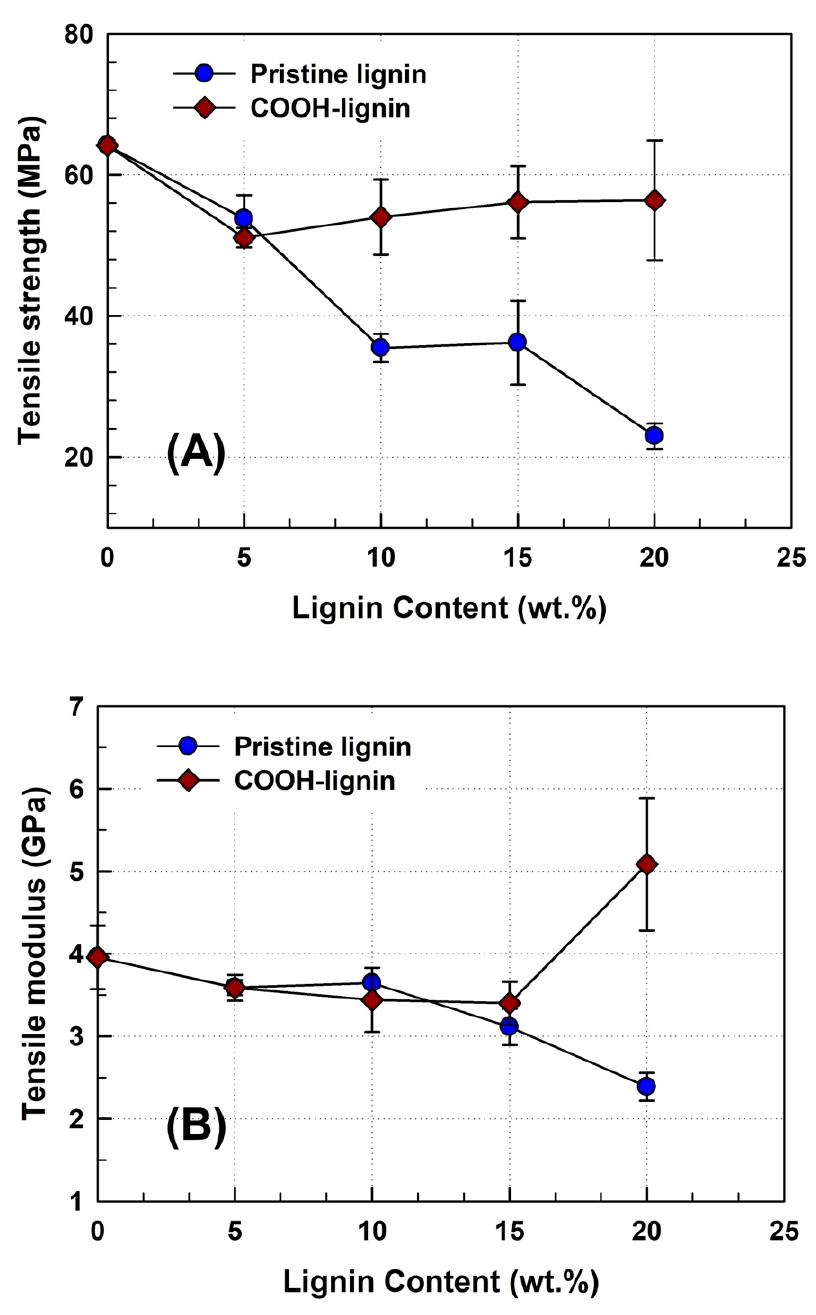
Figure 4. Effect of pristine lignin and COOH-lignin content on the tensile strength ( A ) and tensile modulus ( B ) of the PLA-based biocomposites.